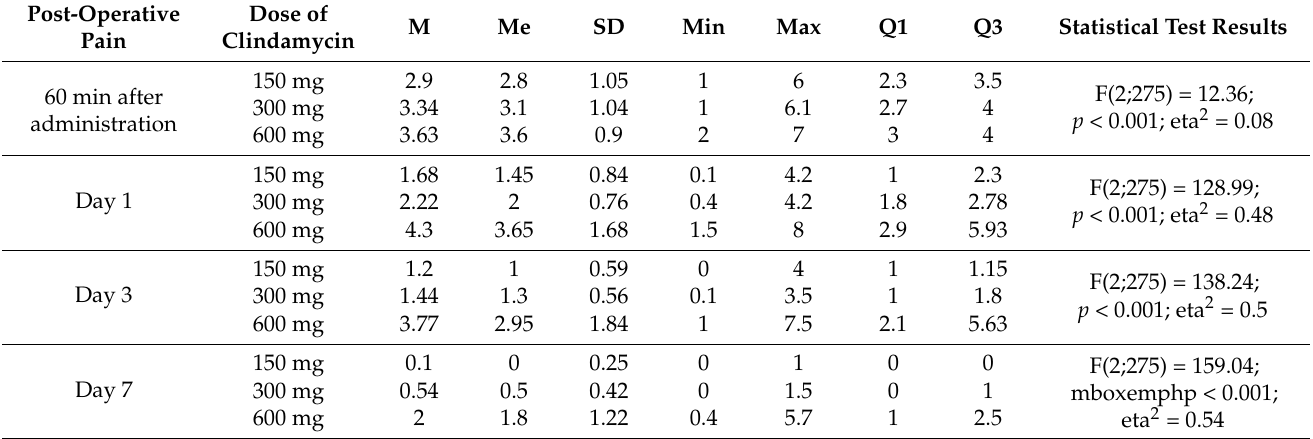
Table 7. Descriptive statistics of post-operative pain in the study groups.